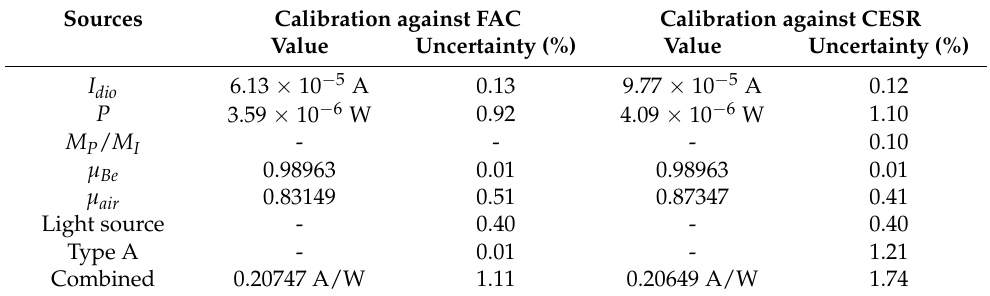
Table 3. Uncertainties of calibrations of the photodiode spectral responsivity ( k = 1) against the FAC and the CESR.